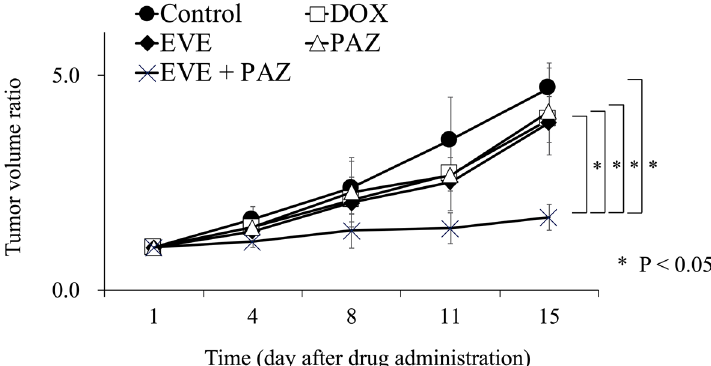
Figure 2. Efficacy of drugs on osteosarcoma growth in the PDOX mouse model. Line graphs express the tumor volume ratio, which is the tumor volume at any given time point relative to tumor volume at the beginning of the experiment. Line graphs express the average and error bars show ± standard deviation. Statistical analysis was performed using the Steel–Dwass test. *P < 0.05.